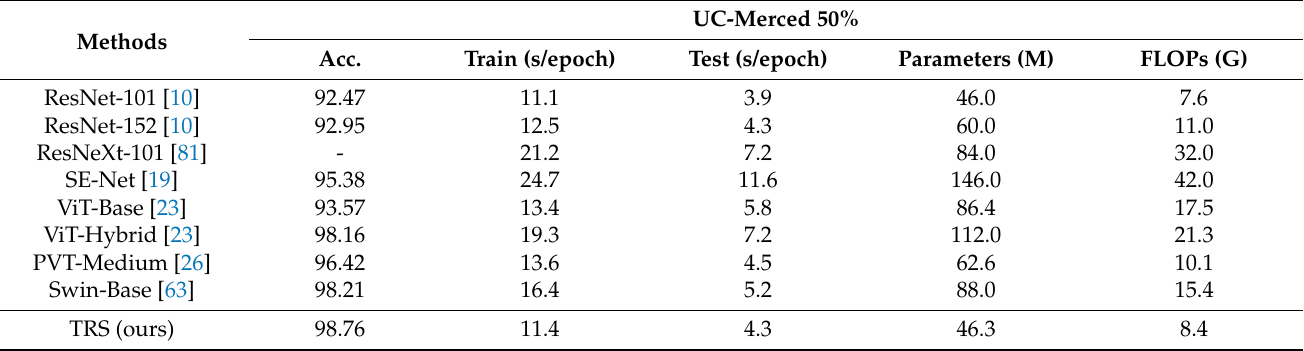
Table 10. Compare training and testing time and Parameters with other models.